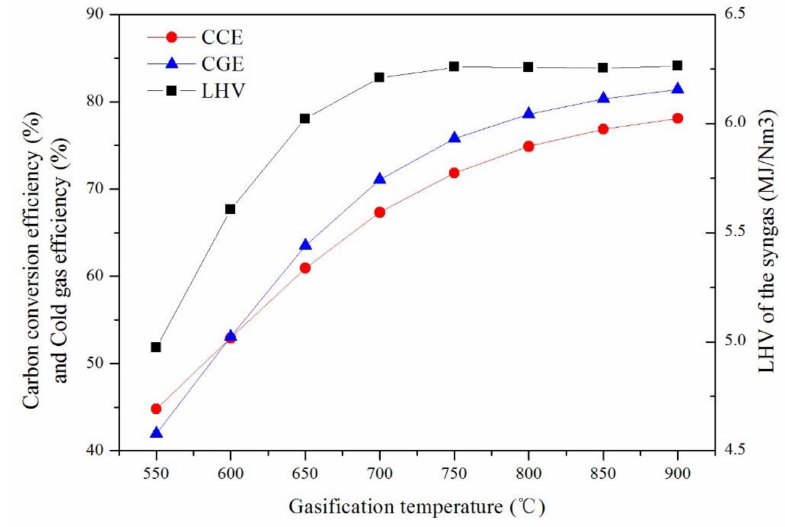
Figure 8. E ff ect of gasification temperature on CCE, CGE, and LHV (Simulation, ER = 0.2, S / C = 2).